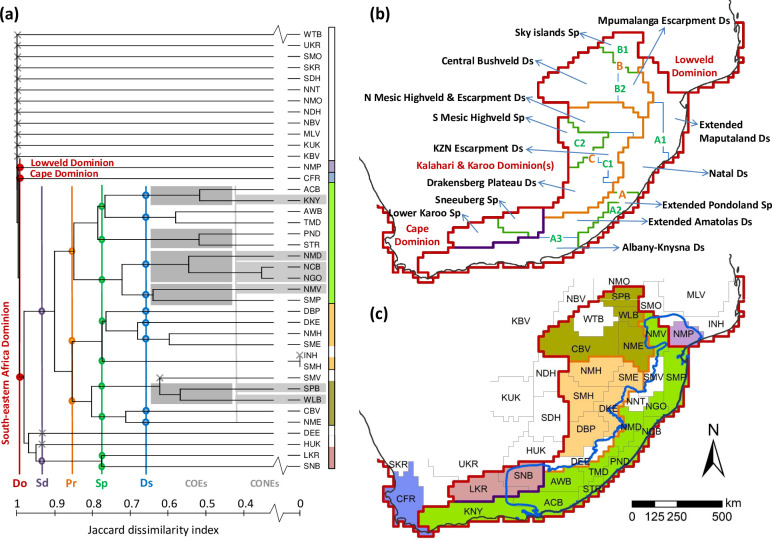
Proposed zoogeographical regionalisation for land snails of south-eastern Africa.(a) Dendrogram of hierarchical relationships between operational geographic units (OGUs), based on UPGMA clustering with Jaccard’s coefficient of similarity. The hierarchy of zoogeographical entities were established using phenon lines of increasing similarity: Do = dominion; Sd = subdominions; Pr = provinces; Sp = subprovinces and Ds = districts. Centres of endemism (dark grey) and centres of narrow endemism (light grey) are also recognized from the same dendrogram, and mapped in Fig 4. Three letter codes for OGU names follow Fig 1. (b) The proposed hierarchical zoogeographical regionalisation of the South-Eastern Africa (SEA) dominion (thick dark red boundary; Lowveld and Cape dominions respectively in north-east and south-west are also indicated). The coloured phenon lines in panel (a) defines subdominions, provinces, subprovinces and districts of the SEA dominion, listed in Table 1, with respective codes for provinces (A-C), subprovinces (A1, A2, etc.). Entities labelled on the map are subprovinces (Sp) and districts (Ds); S = South, N = North and KZN = KwaZulu-Natal. (c) Malacofaunal provinces within the two subdominions of SEA dominion (separated by thick purple boundary): MPA-Highveld subdominion with three provinces—MPA-Knysna province (light green), Highveld province (pale orange) and Bushveld province (olive green); and southern escarpment subdominion with no subordinate provinces (pale maroon). OGUs shown here in white (and marked with × on the dendrogram) do not form geographically contiguous clusters, and were hence dissolved into the geographically nearest and ecologically closest biogeographical entity (see discussion for more details). MPA hotspot boundary is reprinted from Hoffman et al. [26] (public domain) in blue to show its recovery as a valid zoogeographical entity (MPA-Knysna province), despite an extension towards Knysna in south-west.